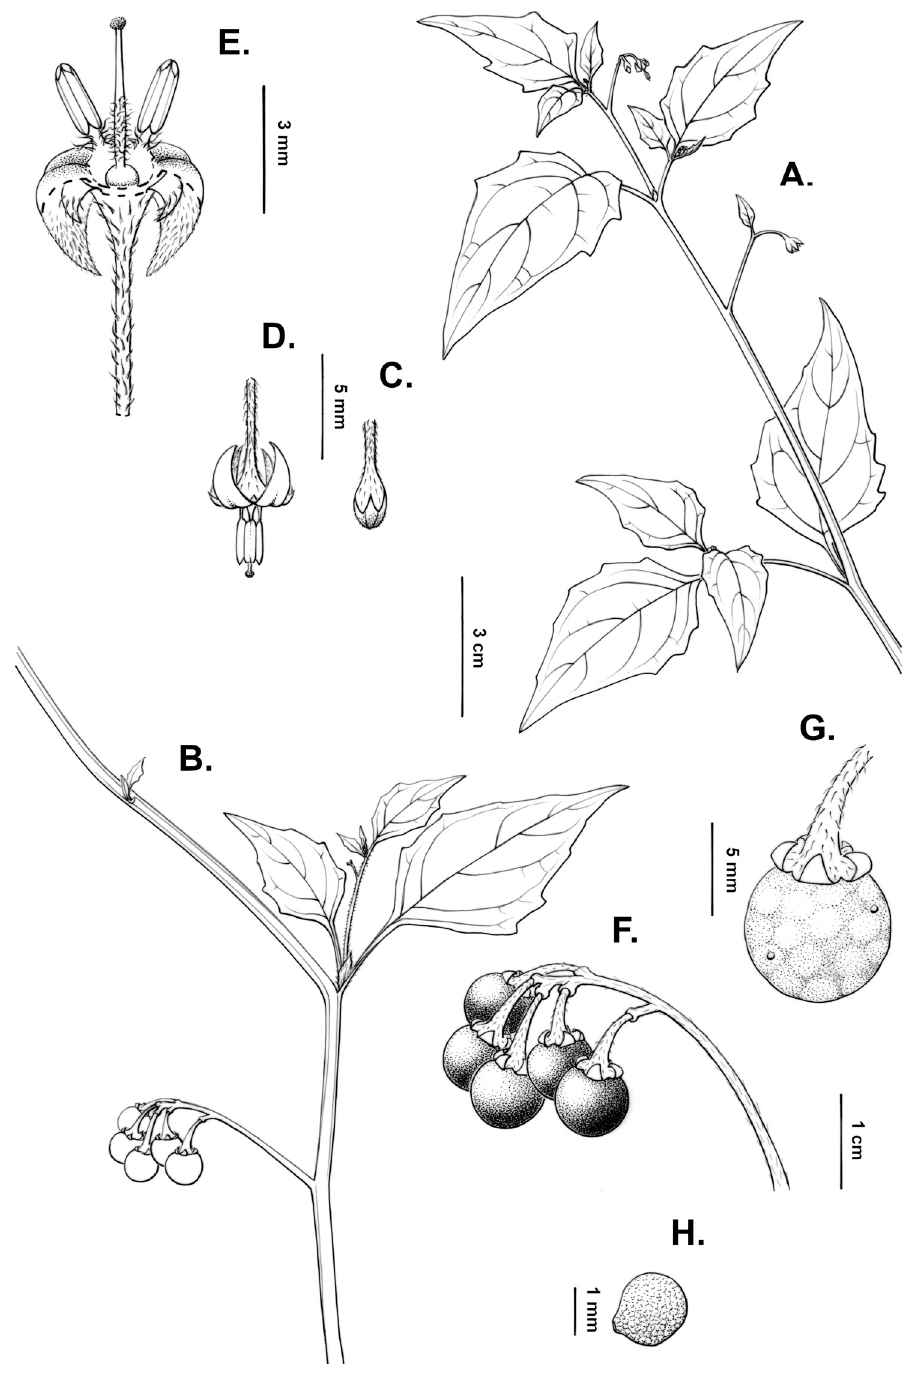
Figure 21. Solanum interius Rydb. A Habit B fruiting habit C bud D flower E dissected flower F mature fruits G dried berry H seed ( A–H Wooton 50 ). Drawing by C.